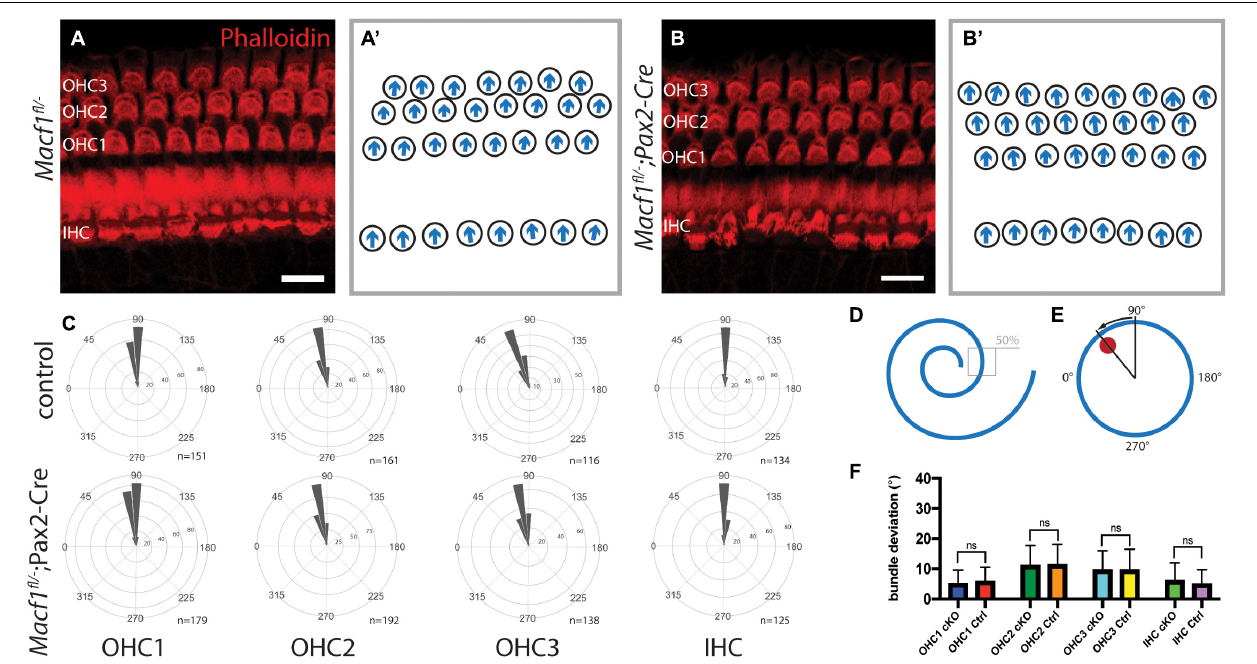
FIGURE 3 | Auditory hair cell PCP is not affected in Macf1 fl / − ; Pax2-Cre mice. (A,A (cid:48) ,B,B (cid:48) ) Cochlear hair cells of one-month old mice, labeled with phalloidin (red), demonstrate hair bundle orientations. (A,B) Maximum projections of stacks of confocal images and (A (cid:48) ,B (cid:48) ) associated schematics of hair bundle orientations. The stacks are centered around the cuticular plate level and do not capture the full bundle lengths of all cells, but are meant to reveal PCP only. (C) Orientations of stereociliary bundles plotted on circular histograms for all hair cells from the middle turn of the cochlea ( ∼ 50% cochlear length). 0 ◦ is directed toward the apical turn of the cochlea, and 180 ◦ is toward the base. Bin width is 10 ◦ . The total number of represented hair cells is shown by each histogram ( n ). Scale bars = 10 µ m. (D) Schematic indicating the region located at ∼ 50% along the length of a cochlea for stereociliary bundle orientation analyses. (E) A representative schematic of a single hair bundle demonstrating the angular measurement for quantifying stereociliary bundle deviation. The red dot marks the position of the kinocilium, and the arrow shows the deviation. (F) Averaged bundle deviation from the mediolateral axis of a hair bundle for Macf1 fl / − ; Pax2-Cre (cKO) and control mice. For orientation and bundle deviation assays, the number of mice analyzed is n = 5 for Macf1 fl / − ; Pax2-Cre and n = 4 ( n = 2 for Macf1 fl / − , n = 2 for Macf1 fl / + ; Pax2-Cre ) for controls. Error bars show standard deviation. There is no statistical significance between Macf1 fl / − ; Pax2-Cre and control mice. Calculated using a two-tailed Student’s t -test ( p = 0.129 for OHC1, p = 0.678 for OHC2, p = 0.959 for OHC3, p = 0.110 for